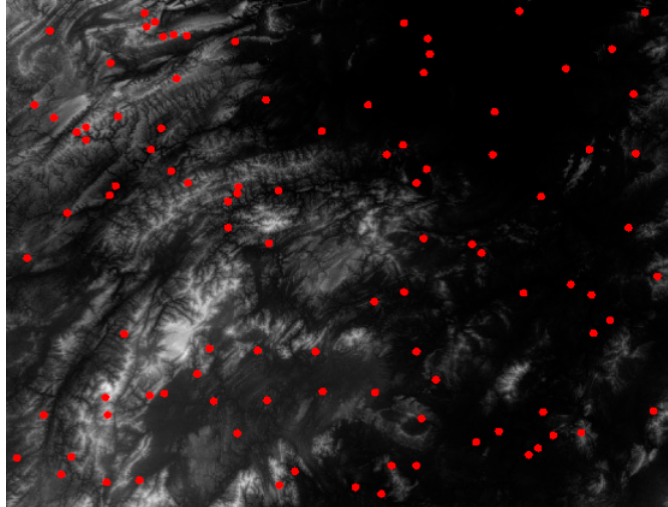
Figure 5. A 11264 by 9152 DEM of a mountainous area in Hunan Province, China. Randomly select 100 positions when the radius equals 100.